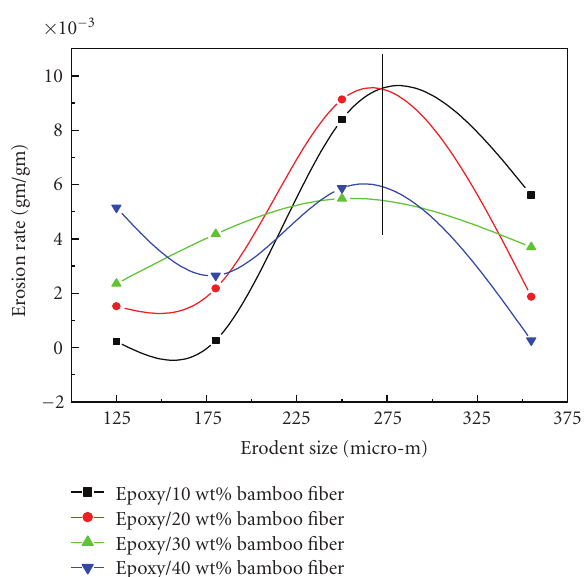
Figure 11: E ff ect of erodent size on the erosion wear rate of the